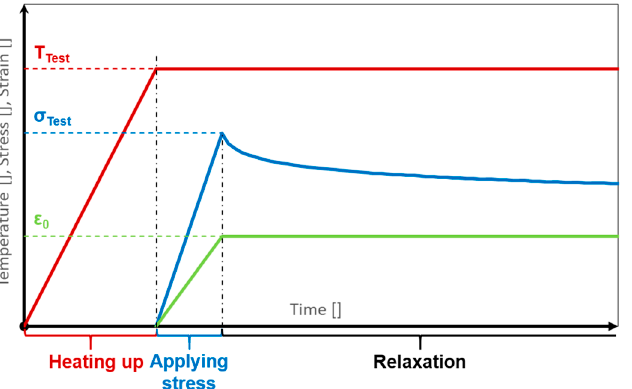
Figure 4. Scheme of the stress relaxation tests showing a first heating and temperature stabilization stage without loading, followed by deformation up to a constant strain. Over time, the stresses get relaxed.